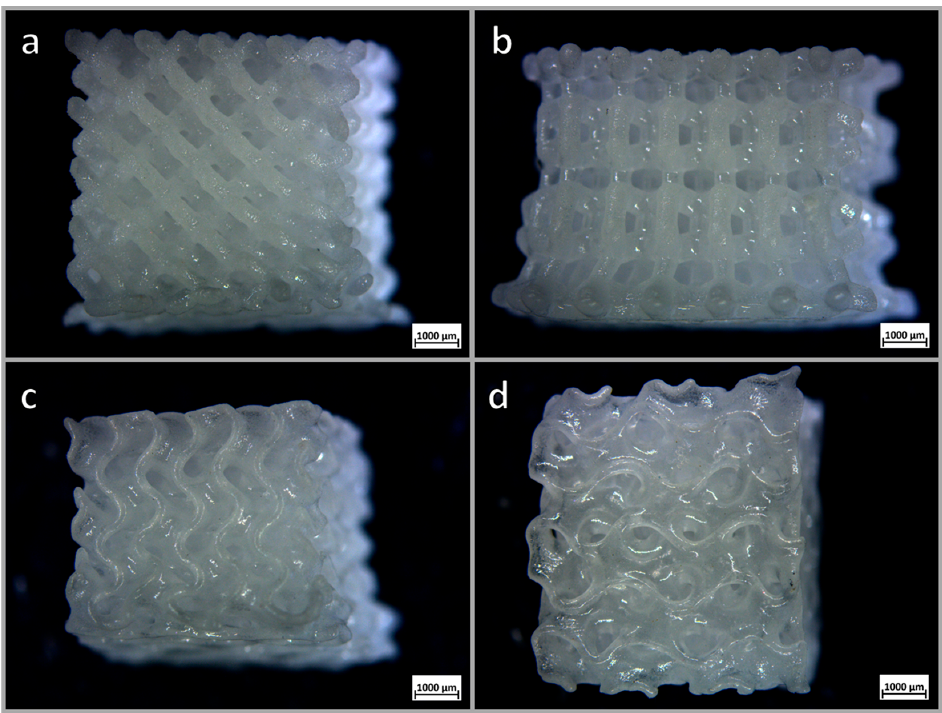
Figure 8. Optical stereomicrographs of MSLA scaffolds after firing at 950 °C: ( a ) diamond cell scaffold; ( b ) wurtzite cell scaffold; ( c , d ) gyroid (side and bottom views).